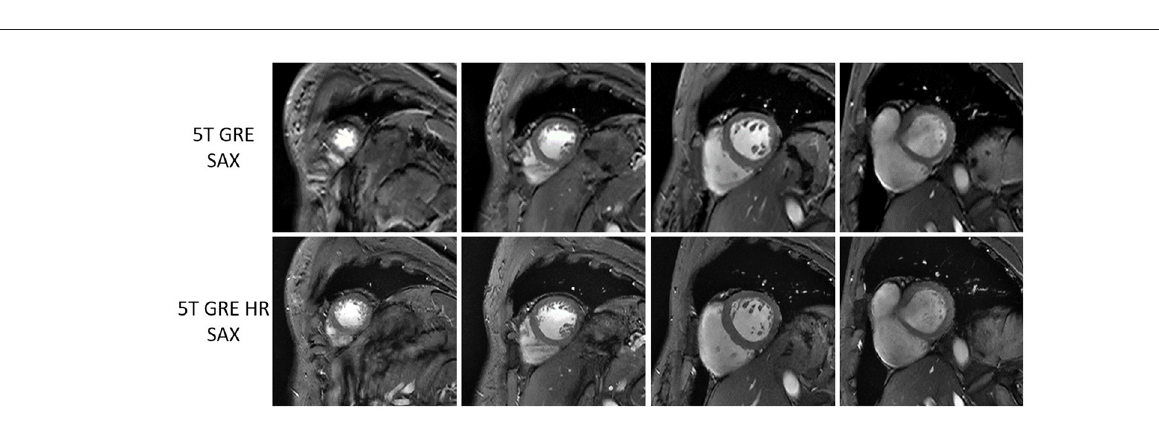
other hand, the 5T GRE results, under the same